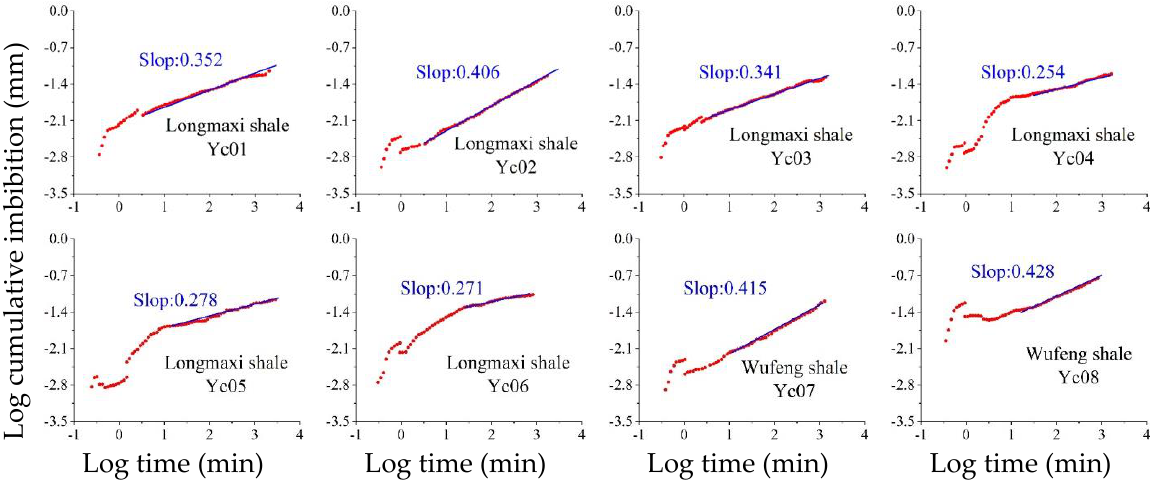
Figure 5. Log plot of the cumulative imbibition of n -decane for shale samples from the Longmaxi and Wufeng Formations.